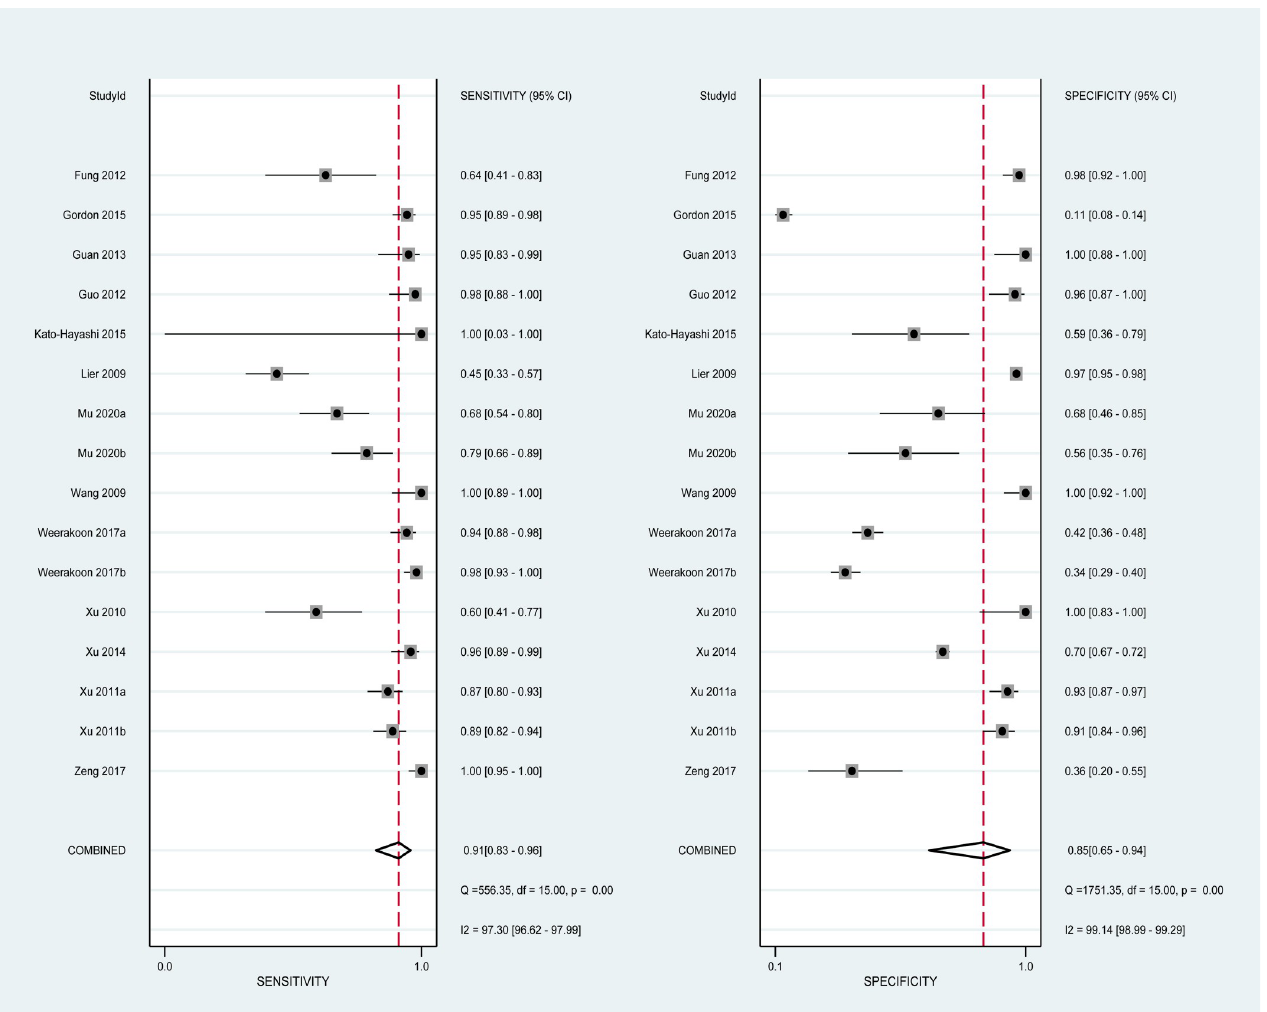
Fig 2. Paired forests of pooled sensitivity and specificity of all included